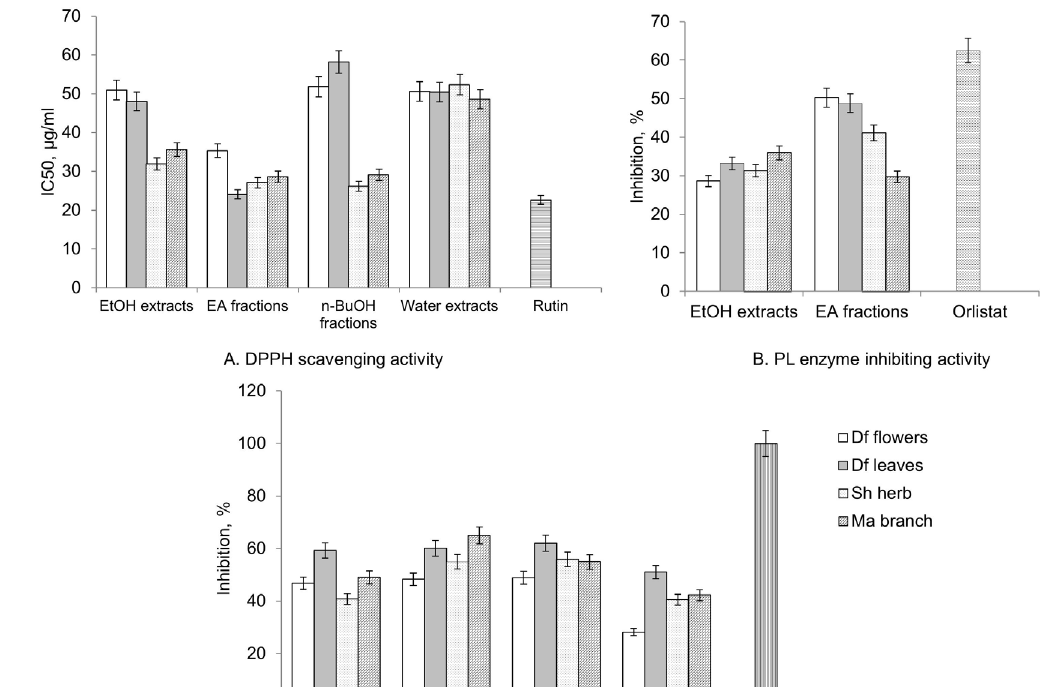
Fig. 1. Biological activities of crude extracts and